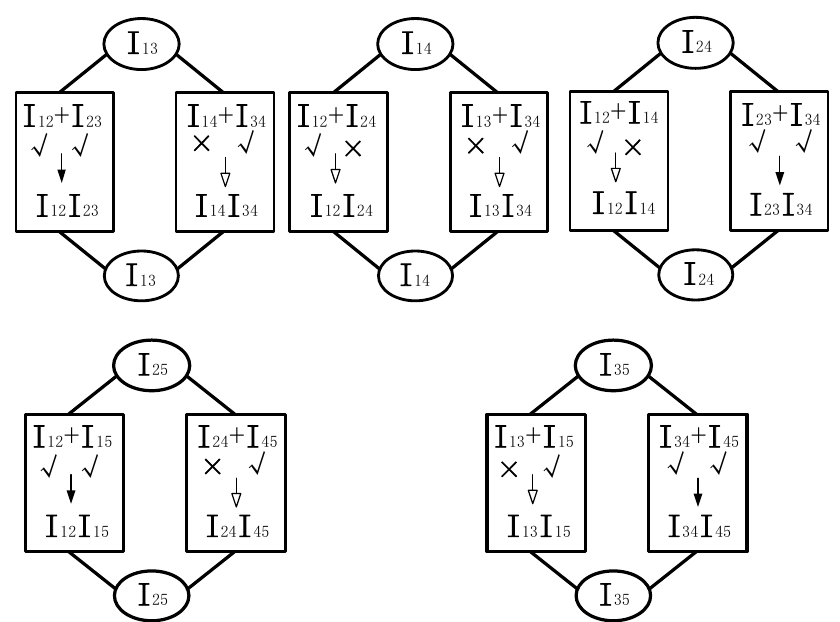
Figure 8. The instant center identification process graph of five-bar planar linkage without virtual links. Table 2. Instant centers of five-bar planar linkage.